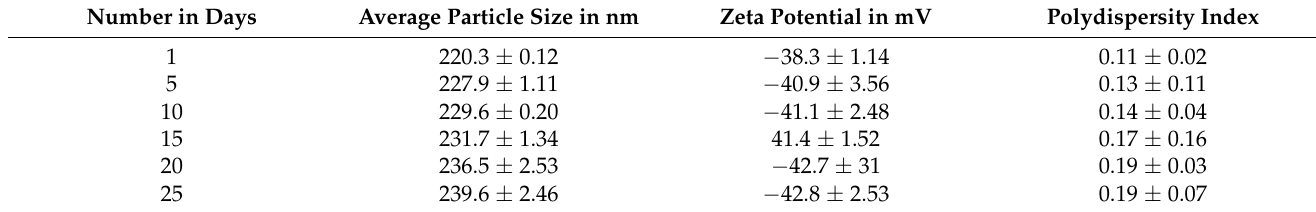
Table 5. The in vitro storage stability for MoP at 25 ◦ C, room temperature. The data are expressed as mean ±